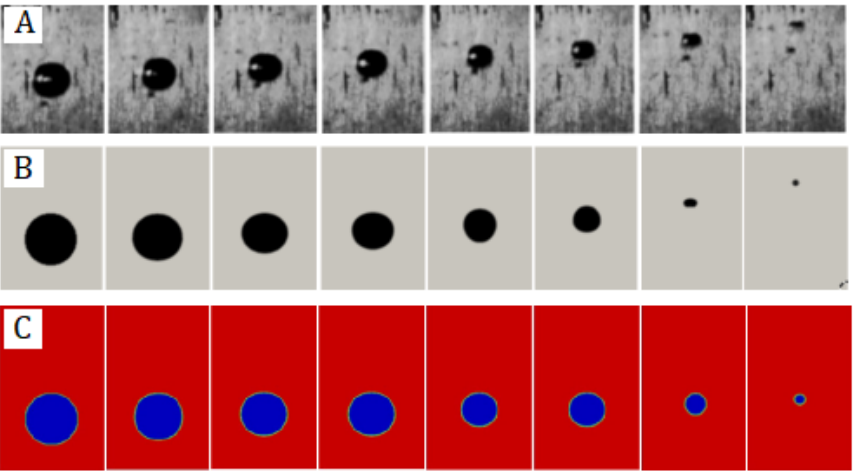
Figure 4. Vapor bubble shape sequence, ( A ): experimental study [43] reproduced with permis sion from Elsevier, ( B ): present numerical simulation with Fourier model ( δ ∼ 0.2 D 0 ), ( C ): numerical simulation with Tanasawa model [28].